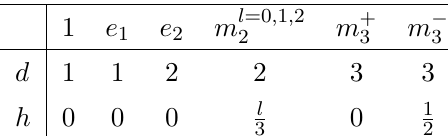
Table 2 . The eight anyons of the quantum double D [ D 3 ]. The total quantum dimension is D D = 6. [ D 3 ]